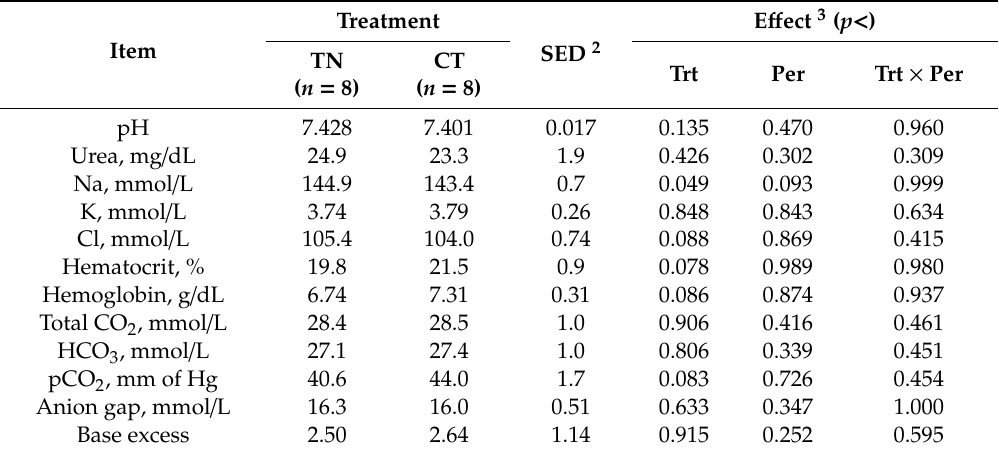
Table 5. Blood metabolites and acid-base indicators in dairy goats under thermoneutral (TN, 15 to 20 ◦ C) or cold temperature (CT, − 3 to 6 ◦ C) conditions 1